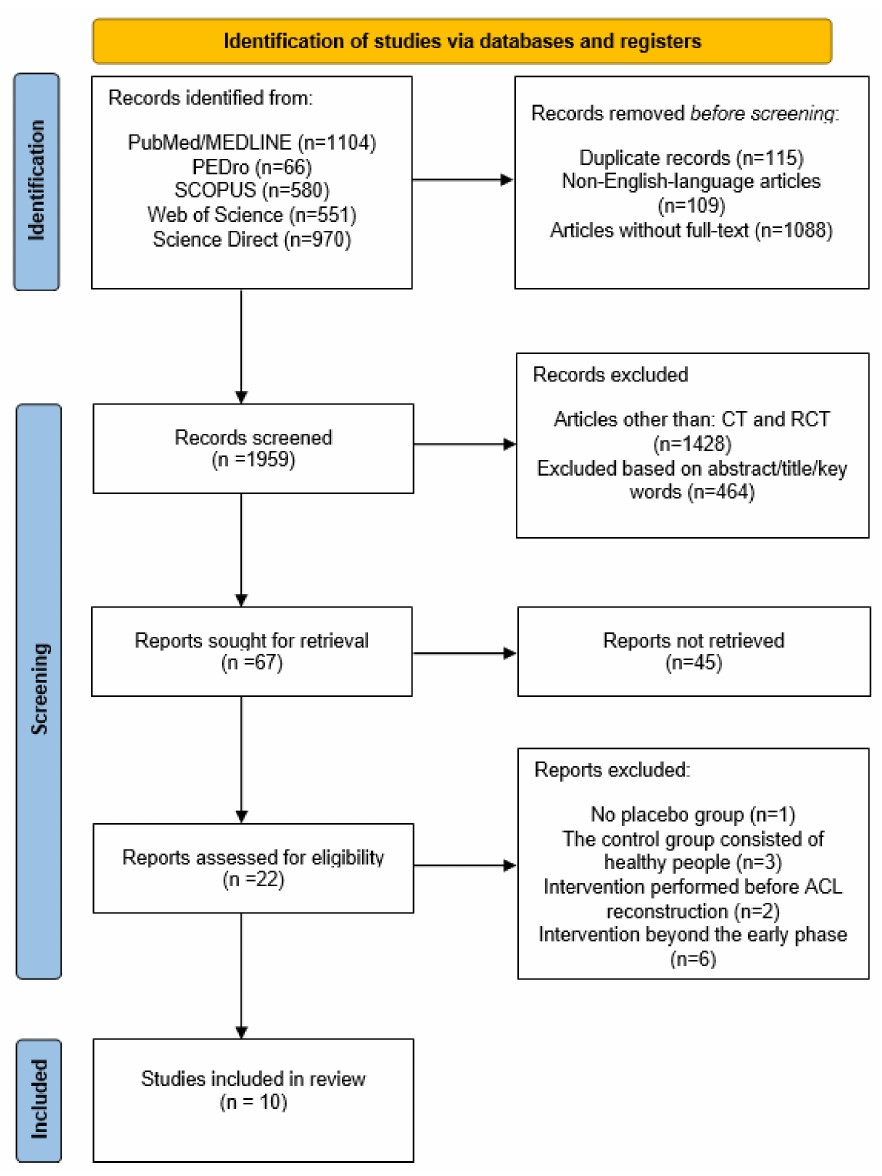
Figure 1. Flow chart with summary of database